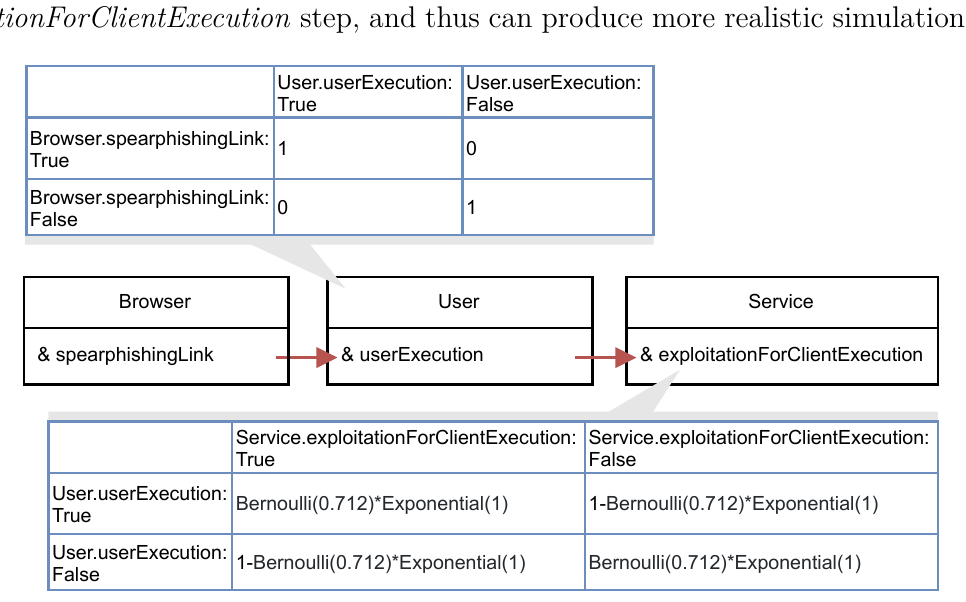
Figure 3. Example of binary and probabilistic relations between attack